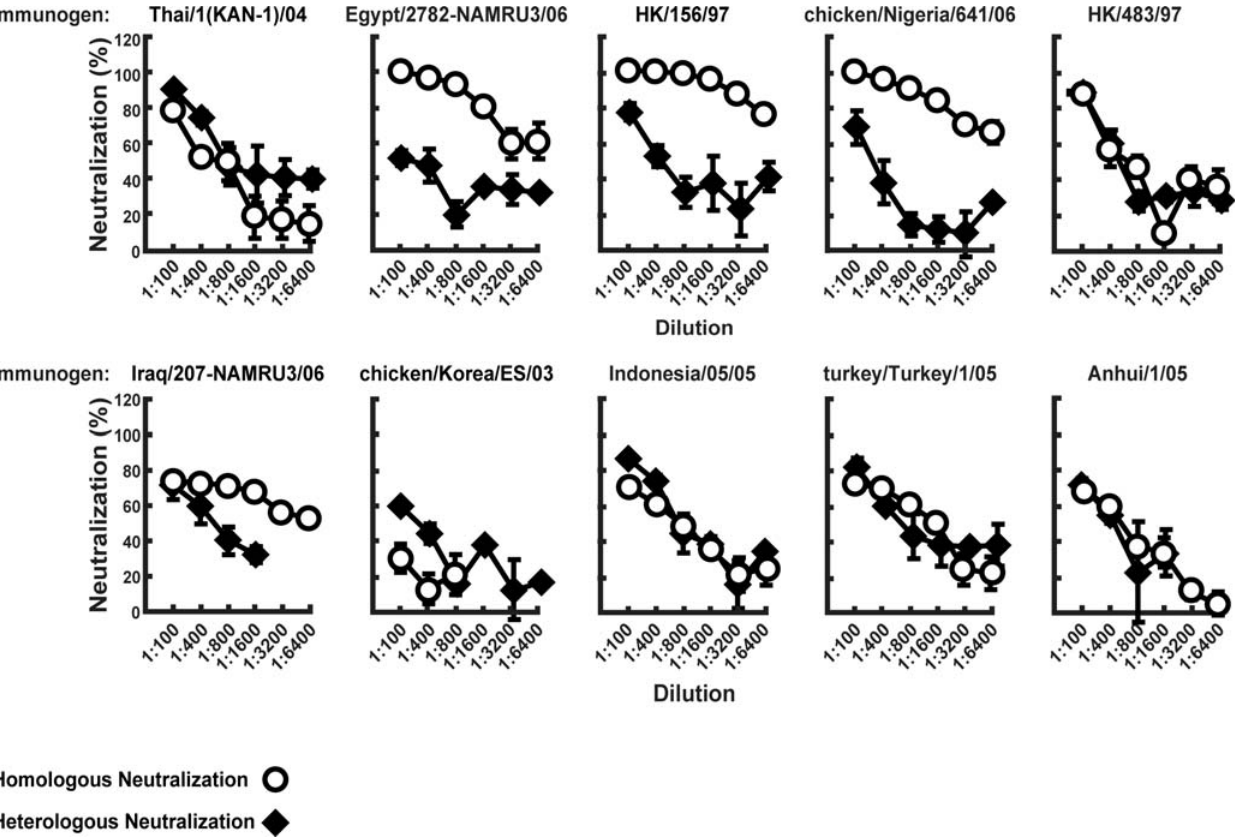
Figure 1. Sera from mice immunized with plasmid DNA vaccines encoding HA from specific strains neutralize a homologous and a heterologous HA with differing efficacy. Groups of mice (n=10) were immunized as described in Materials and Methods with 15 m g of individual H5 HA DNA expression vectors, pCMV/R 8 k B, encoding the HA of indicated viruses: A/Indonesia/05/2005, A/Anhui/1/2005, A/Thailand/ 1(KAN-1)/2004, A/Hong Kong/156/1997, A/Hong Kong/483/1997, A/chicken/Korea/ES/2003, A/turkey/Turkey/1/2005, A/Egypt/2782-NAMRU3/2006, A/chicken/Nigeria/641/2006, and A/Iraq/207-NAMRU3/2006. Sera was collected from each group 14 days after the third immunization, pooled, and tested against the homologous (open circles) or a heterologous HA, A/Vietnam/1203/2004 (black diamonds). Serum from each group was serially diluted (1:100 to 1:6400) and analyzed by LAI. Error bars at each point indicate the standard deviation; each sample was evaluated in triplicate. Different degrees of neutralization among various H5 pseudoviruses were observed among different HA-immunized mice. groups: A/Indonesia/5/05 (p = 0.377), 10 HA (p = 0.082), 5 HA (Set 1) (p =0.101), or 5 HA (Set 2) (p = .411). Therefore, we cannot